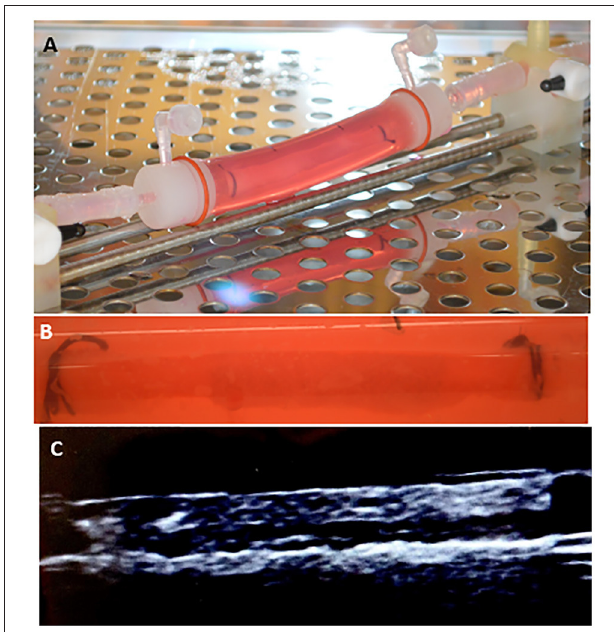
FIGURE 6 | Arterial drug retention of a drug eluting stent. (A,B) Image of the drug eluting stent deployed within the explanted pig artery. (C) Ultrasound image showing the stented explanted